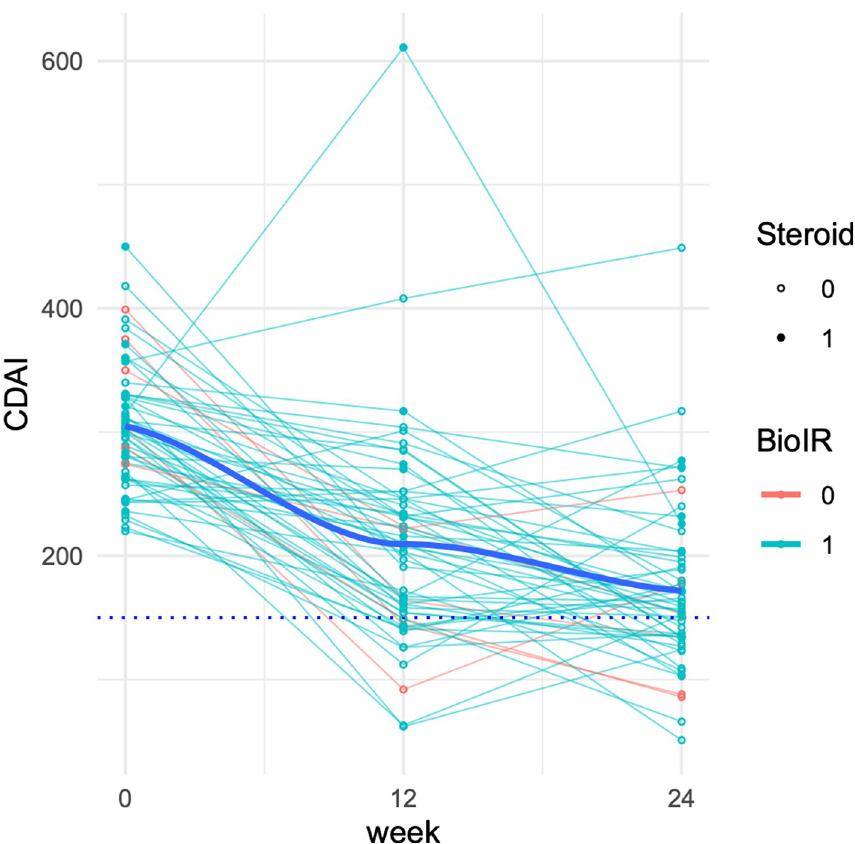
Fig 4. Change in the Crohn’s Disease Activity Index (CDAI) over time. Lines correspond to individual patient trajectories, where turquoise corresponds to patients who were biologic-intolerant or refractory (BioIR) and red corresponds to patients who were biologic-na ï ve. Open circles represent time points where the patient was not receiving oral steroids whereas filled circles represent the use oral steroids at a given time.